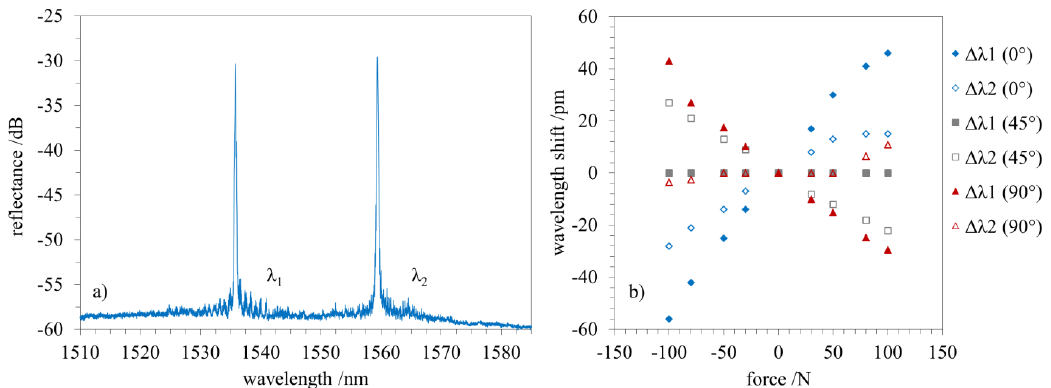
Figure 5. Multi-axial strain sensing using a 2D PPBG. The two angular displaced planar Bragg gratings exhibit an unequal spectral response towards tensile and compressive strain. ( a ) reflected spectrum recorded using a 2 × 2 50/50 coupler; ( b ) sensitivity towards tensile and compressive strain at various